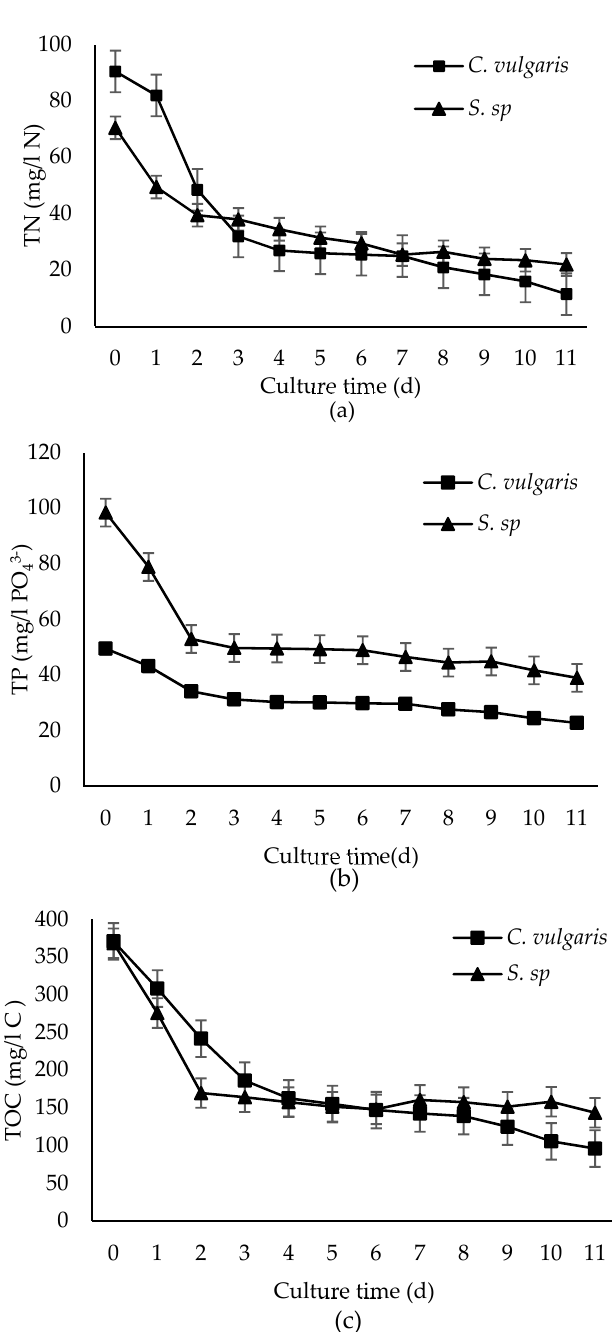
Figure 2. Nutrient consumption of Scenedesmus sp. and Chlorella vulgaris in pig slaughterhouse wastewater for 11 days ( a ) TN (mg/L N) vs. Time, ( b ) TP (mg/L PO 43 − ) vs. Time and ( c ) TOC (mg/L C) vs. Time. The values are presented as means of triplicate measures with their corresponding standard deviation (±SD).